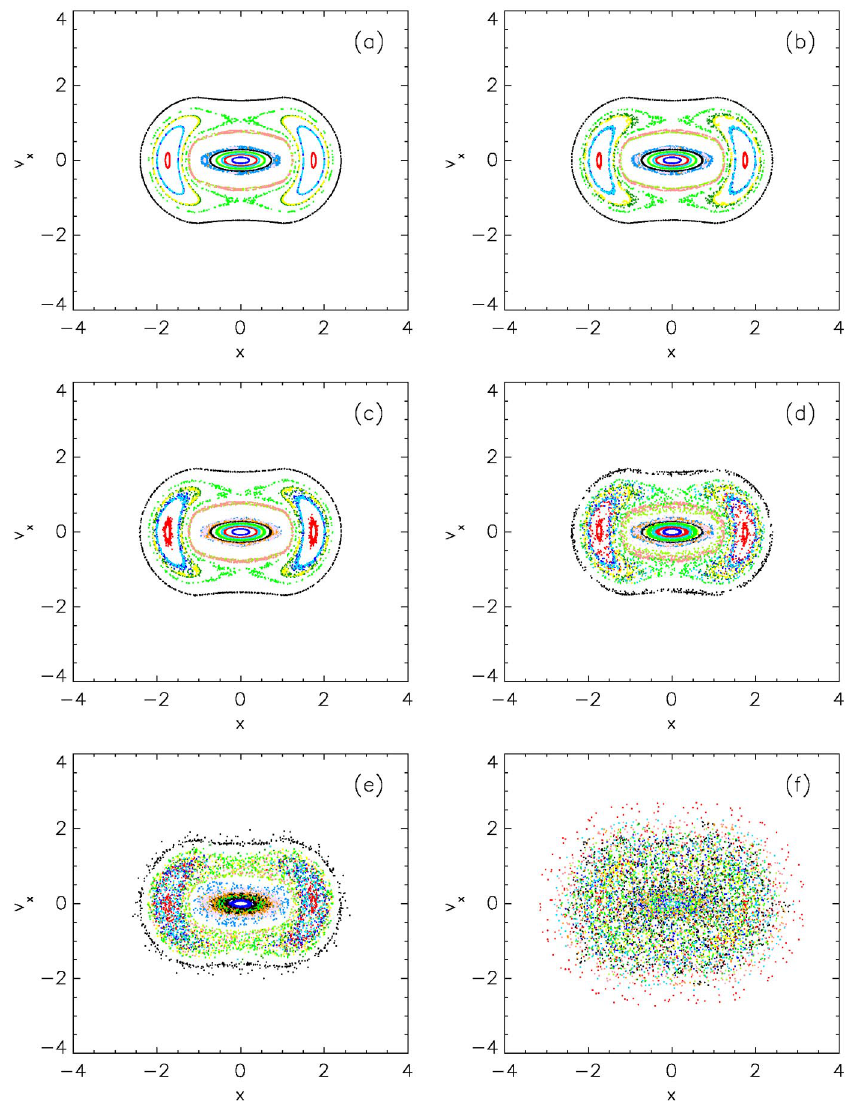
FIG. 9. (Color) Poincare´ sections for a set of 18 representative initial conditions integrated over t (cid:2) 2048 DE units ( (cid:1) 250 t various noise strengths, and with t (d) hj (cid:22)! ji (cid:2) 10 (cid:4) 4 , (e) hj (cid:22)! ji (cid:2) 5 (cid:22) 10 (cid:4) 4 , and (f) hj (cid:22)! ji (cid:2) 10 (cid:4) 3